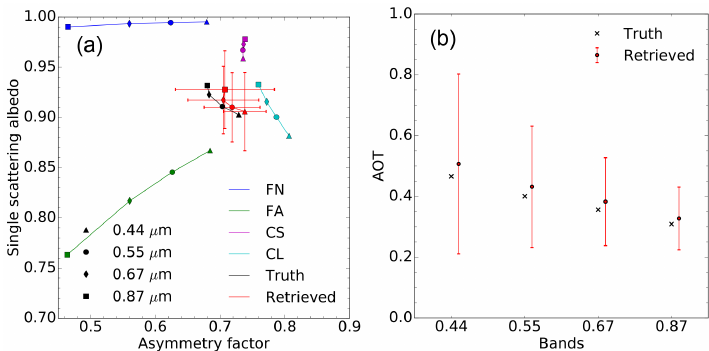
Figure 12. Same as Fig. 5 but for experiment